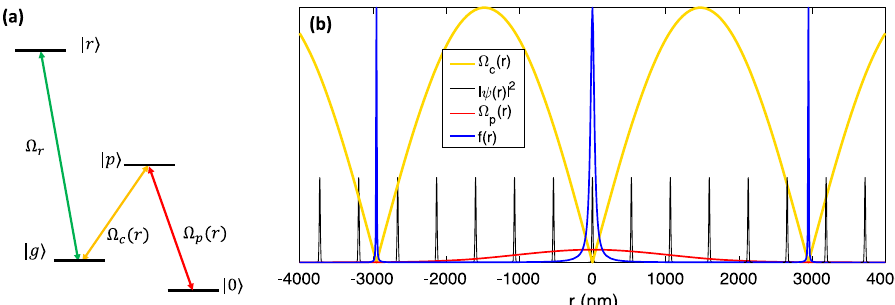
Fig. 10 Dark-state single site addressing technique. a the level scheme containes a Λ con fi guration transferring the population from 0 j i to g j i at the nodes of Ω c standing-wave where Ω c ≪ Ω p . The transferred atom would then get excited to the Rydberg state. b The spatial pro fi le of the transition Rabi frequencies Ω c , p as well as the 0 j i g h j transition probabilities f ( x ) and the wave-function density ∣ ψ ( x ) ∣ 2 of the atoms in 0 j i qubit states are plotted. f ( r ) maps the ∣ ψ ( x ) ∣ 2 to g j i state upon the spatial overlap which is designed to only occurs at the targeted site. b Sample applied parameters are Ω c / Ω p = 30, ~ k ¼ 1 μ m (cid:2) 1 and the Gaussian width of Ω = 2 μ p laser is w plaquette atom. Here a is the distance vector between centered and a plaquette site, and one needs to average over the laser misalignment r l and also over the position of the plaquette atom r p considering its Wannier wave-function to fi nd the average loss of a plaquette atom (cid:1) E p in 1 j i state. The variation of the averaged plaquette error is plotted by solid lines in Fig. 9a, b as a function of U LS / Ω . The Oscillation is due to the change of effective Rabi frequency ~ Ω , which leads to different values of Rydberg leakage at the plaquette sites after the gate operation. At large U LS / Ω and also for weak laser focusing (large w ) the variation of detuning over the plaquette atoms ’ wave-functions would be large and hence averaging the error over r 1 and r p washes the oscillation pattern. The laser cross-talk could be suppressed by using atom error (cid:1) E c , Fig. 9 shows that single-site operations with high fi delity is achievable in the designed setups discussed in the main text.